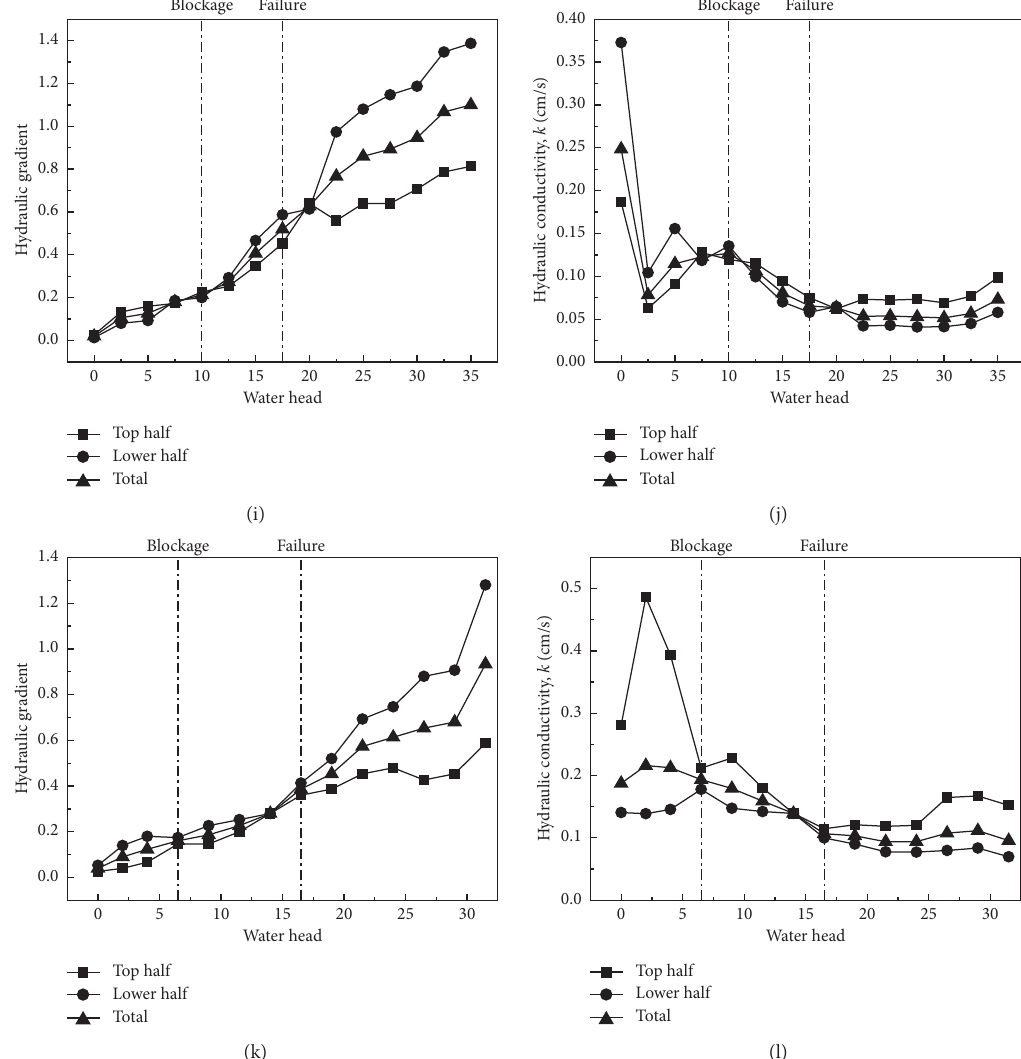
Figure 13: Variation of hydraulic gradient and hydraulic conductivity with water head for the CS group. (a) Variation of hydraulic gradient with water head for CS-0. (b) Variation of hydraulic conductivity with water head for CS-0. (c) Variation of hydraulic gradient with water head for CS-1. (d) Variation of hydraulic conductivity with water head for CS-1. (e) Variation of hydraulic gradient with water head for CS- 2. (f) Variation of hydraulic conductivity with water head for CS-2. (g) Variation of hydraulic gradient with water head for CS-3. (h) Variation of hydraulic conductivity with water head for CS-3. (i) Variation of hydraulic gradient with water head for CS-4. (j) Variation of hydraulic conductivity with water head for CS-4. (k) Variation of hydraulic gradient with water head for CS-5. (l) Variation of hydraulic conductivity with water head for